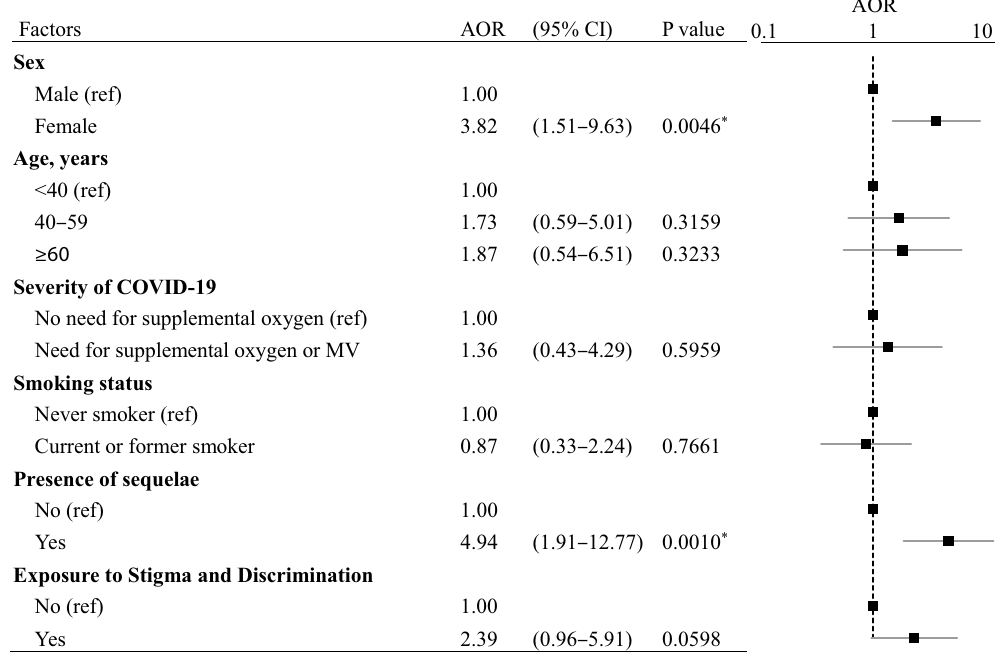
Table 3. Multivariate analysis results of risk factors for psychological distress (K6 Scores ≥ 5). N = 127, R 2 = 0.1932, Model p < 0.0001. Analyses were conducted using a multivariate logistic regression model.